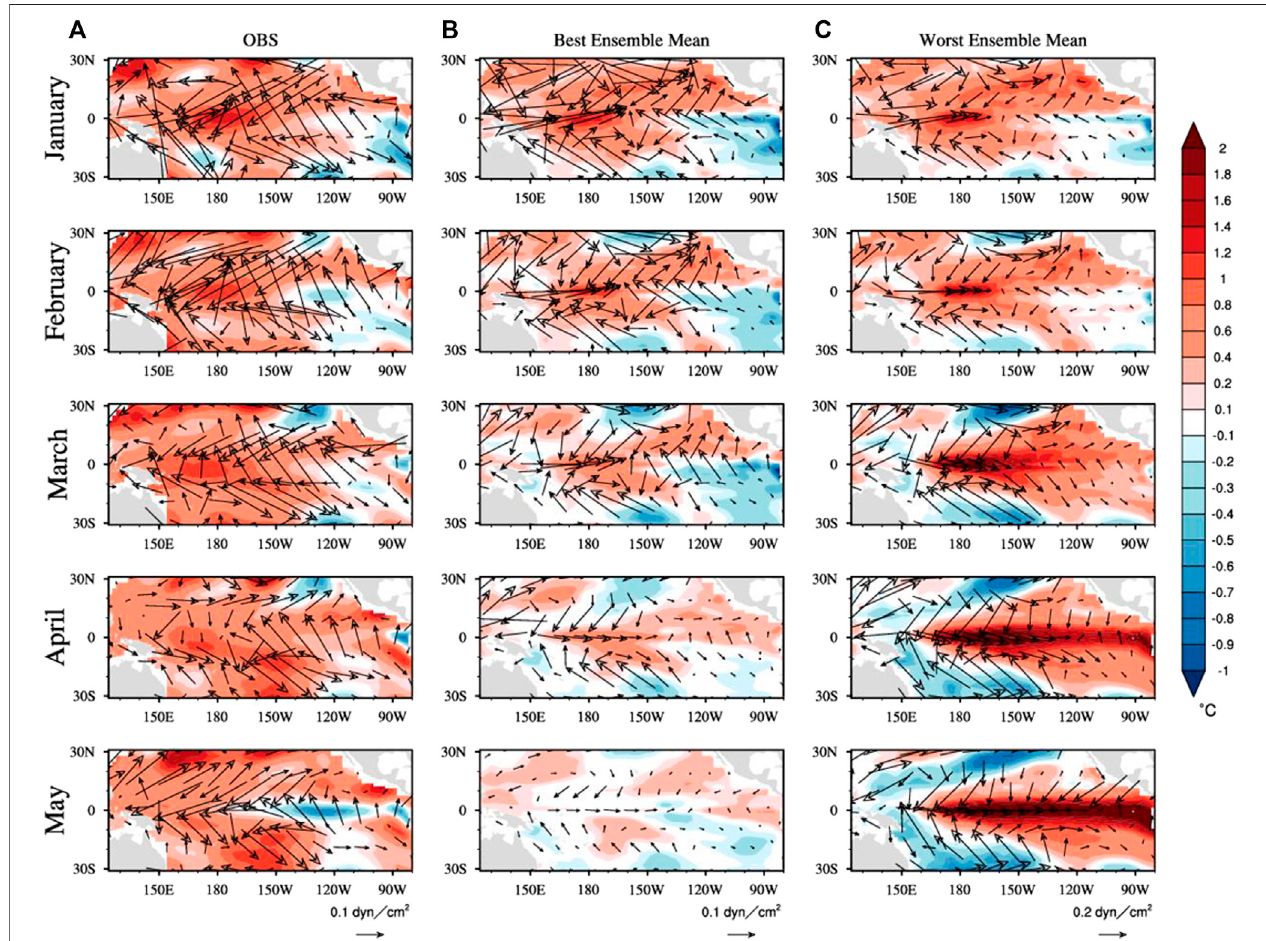
FIGURE6| Temporalevolutionofwindstressanomalies(vectors)andSSTA(shading)(30 ° S-30 ° N,120 ° E-80 ° W)fromJanuarytoMay2020[ (A) :observations; (B) : the ensemble mean of the best prediction members by pattern clustering; and (C) : the ensemble mean of the worst prediction members by pattern clustering].